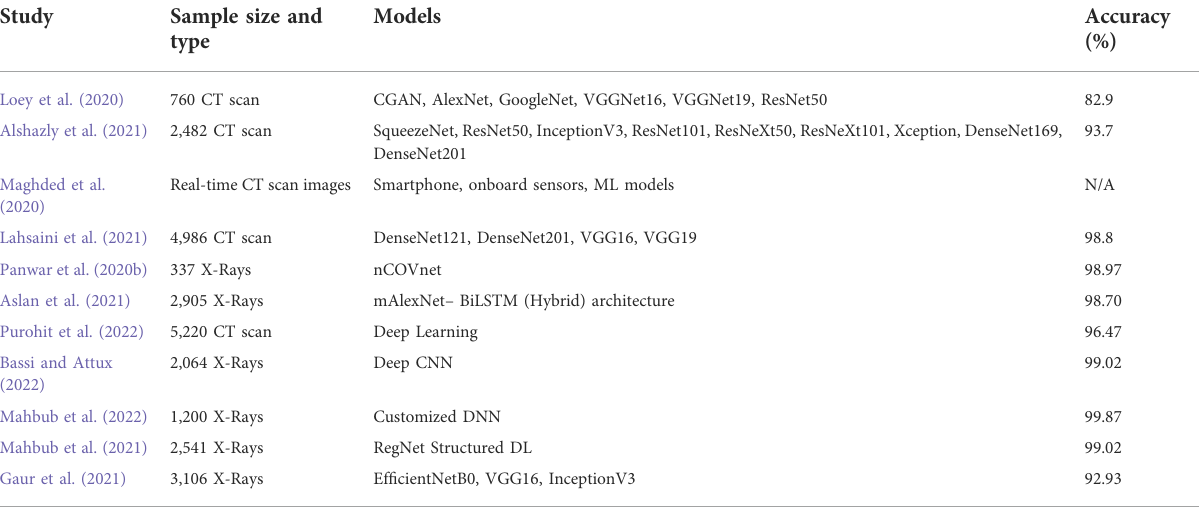
TABLE 1 Studies evaluating DL methods for COVID-19 identi fi